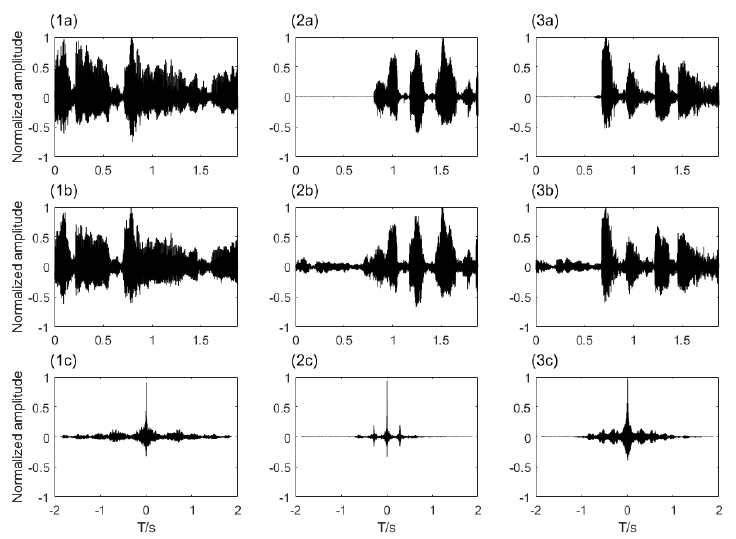
Figure 11. Original signals ( a ), reconstructed signals ( b ), and the cross − correlation function ( c ) be- tween them: ( 1 ) s 1 , ( 2 ) s 2 , and ( 3 ) s 3